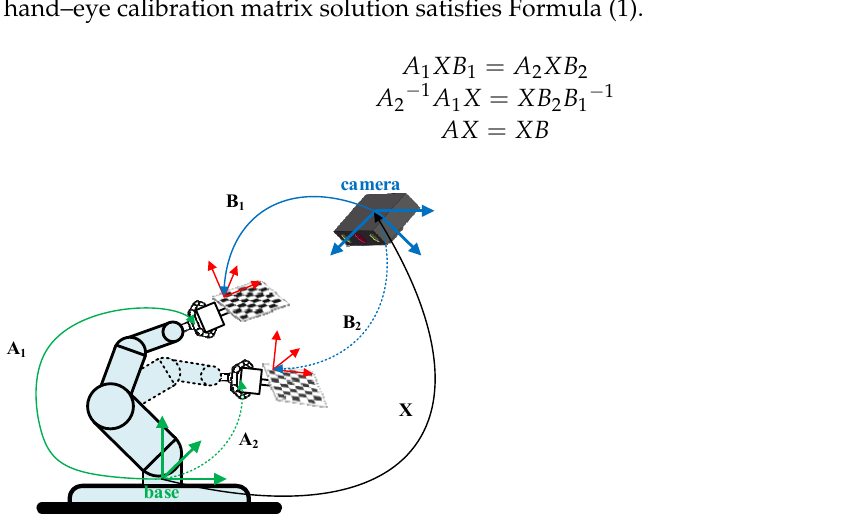
Figure 2. Schematic diagram of hand–eye calibration: ( i = 1, 2) represents the transformation matrix from the robot base coordinate system to the robot end coordinate system; (i = 1, 2) represents the transformation matrix from the camera coordinate system to the calibration object coordinate system; X represents the transformation matrix from the robot base coordinate system to the camera coordinate system, that is, the matrix to be solved.